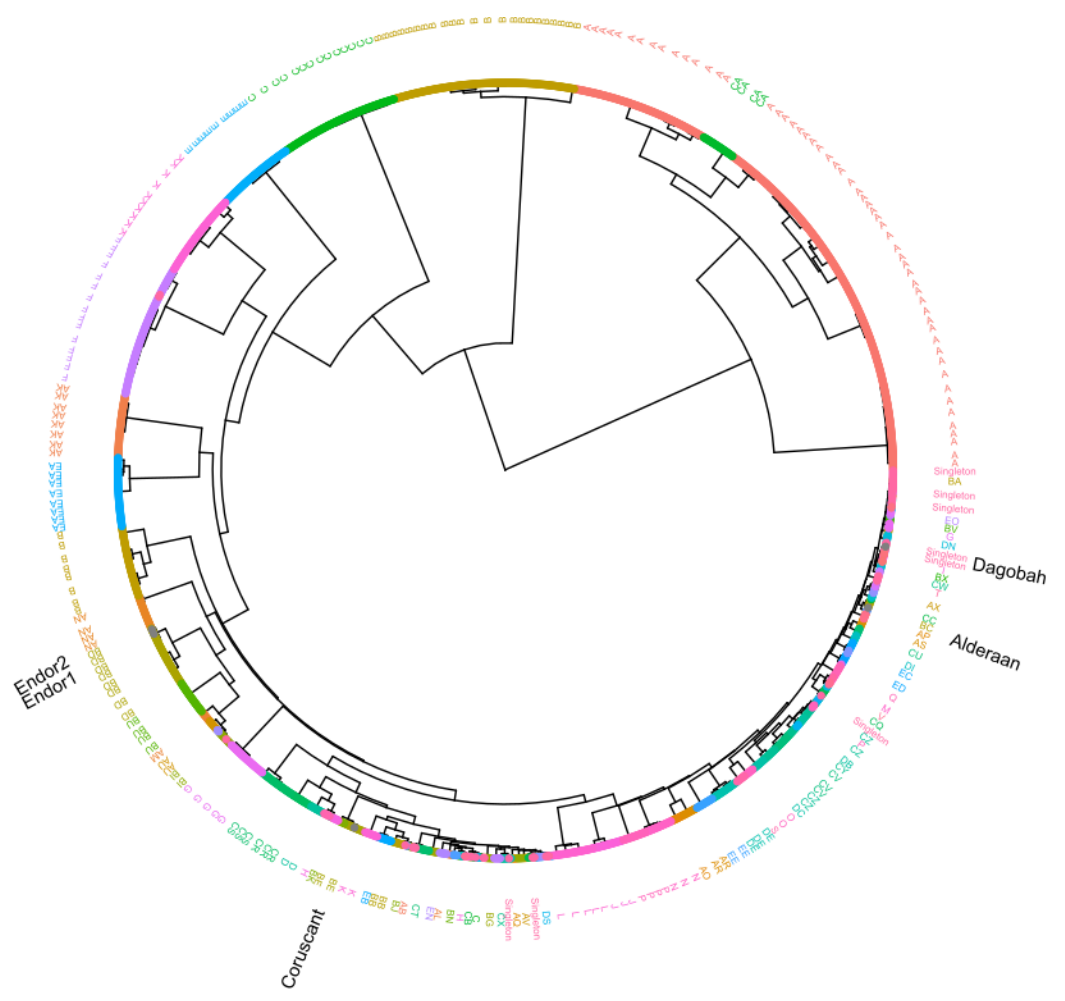
Figure 5 . Protein domain-based hierarchical clustering. The dendrogram was constructed based on the presence-absence matrix of the >700 Pfam protein domains identified from 2486 actinophage genomes. Phages are color-coded according to known groups from the Actinobacteriophage Database (https://phagesdb.org/) [31]. The overlapping labels of the outer ring were merged to improve the figure’s readability. The position of the five new phage genomes is indicated as black text.